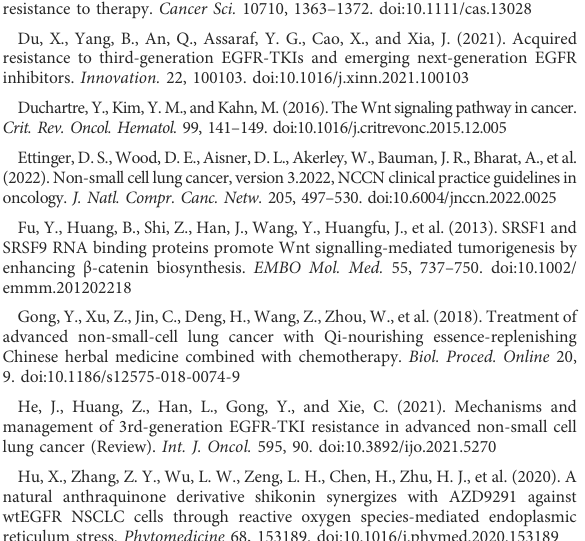
Effects of osimertinib on the proliferation of different lung cancer cell lines. (A) Effects of osimertinib on HCC827 and PC9 osimertinib sensitivity in parental (white) and osimertinib-resistant (gray) cells. Cells were treated with various concentrations of osimertinib for 48 h and tested via the CCK8 assay. (B) Protein levels of PCNA were measured via western blotting. (C) CCK8 results. HCC827OR cells were treated with 4 μ M Osimertinib with FYN and PC9OR cells were treated for 48 h with 6 μ M osimertinib with FYN for 48 h. ~P, parental cell lines; ~OR, osimertinib-resistant cell lines. * p < 0.05, ** p < 0.01, *** p <